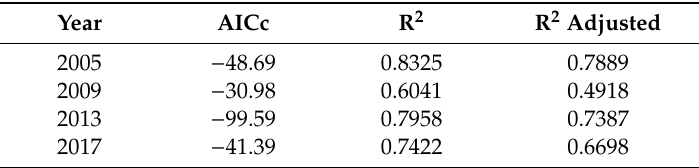
Figure 11. Normalized difference vegetation index (NDVI) geographic weighted regression standardized residuals. Table 5. Normalized difference vegetation index (NDVI) geographic weighted regression fitting parameters.